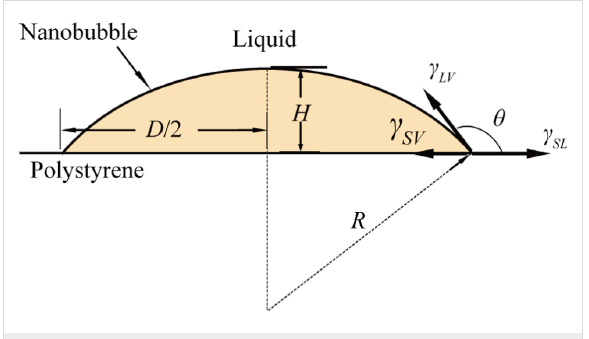
Figure 2: Schematic of a cross section of a NB on a solid PS surface.